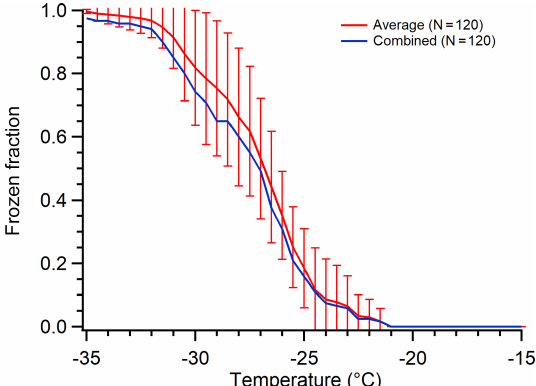
Figure 1. Comparison of averaging data from droplet freezing ex- periments on 120 total droplets measured using three replicate ar- rays of 40 droplets each (red with error bars) versus combining those 120 droplets into one single hypothetical array of droplets (blue). The standard deviation from the average of the three repli- cate arrays is shown by the vertical error